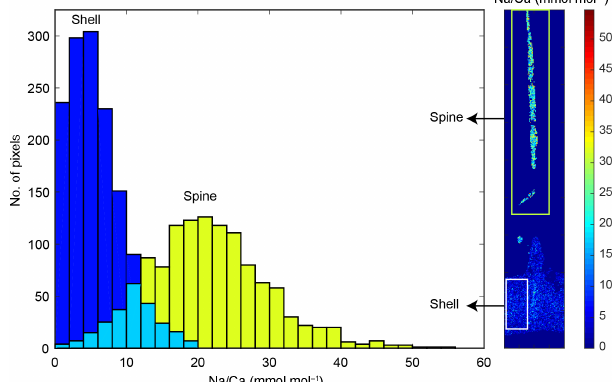
ruber . A weak positive correlation is observed for G. ruber and T. sacculifer between spine width and the size of the foraminiferal shell ( G. ruber : R 2 = 0 . 04, p < 0 . 0001; T. sac- culifer : R 2 = 0 . 04, p = 0 . 004, based on Shapiro–Wilk test; Fig. 4). Spine width correlates negatively with salinity, based on weighted averages of the widths per salinity group for both species ( G. ruber : R 2 = 0 . 35, p < 0 . 0001; T. sacculifer